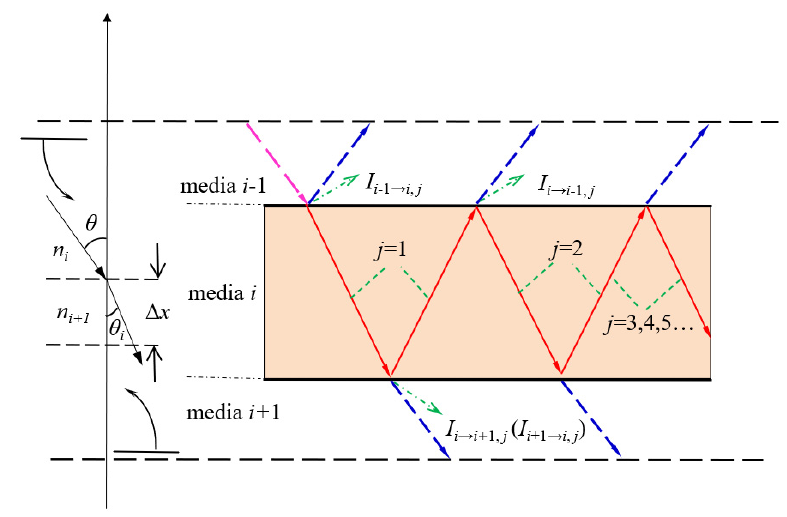
Figure 3. Local spectral vector transmission diagram of thermal insulation structure.